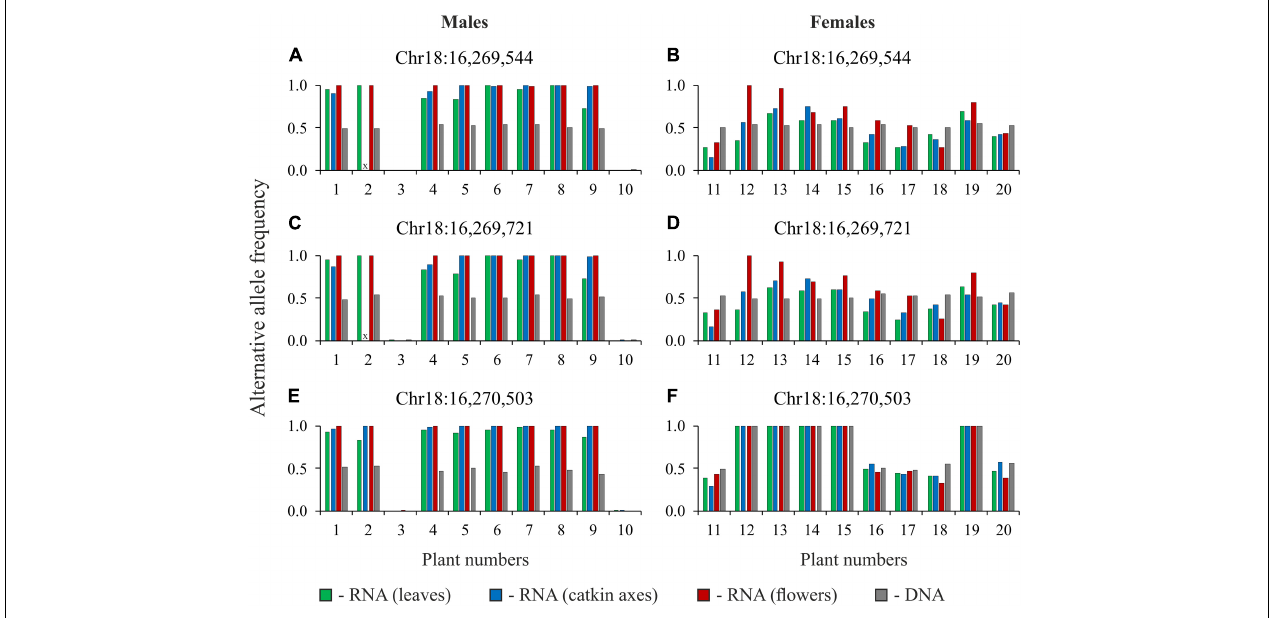
FIGURE 3 | Alternative allele frequencies for heterozygous sites of the CLC gene for DNA and cDNA (RNA from leaves, catkin axes, and flowers) samples of 10 male (A,C,E) and 10 female (B,D,F) plants of Populus × sibirica . Targeted sequencing data; chromosome number and nucleotide position are given above each pair of charts according to the P. trichocarpa “Stettler 14” genome assembly; plant numbers (1–20) correspond to plant numbers in Supplementary Data 7 ; x, no